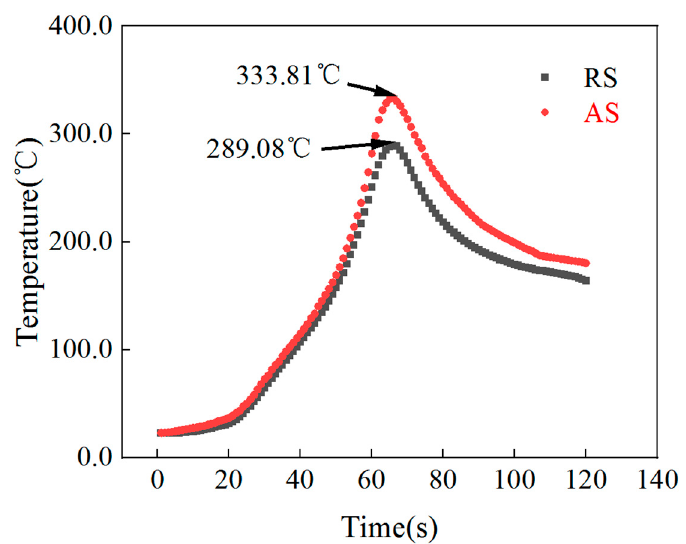
Figure 2. Thermal cycle curves of AS and RS.